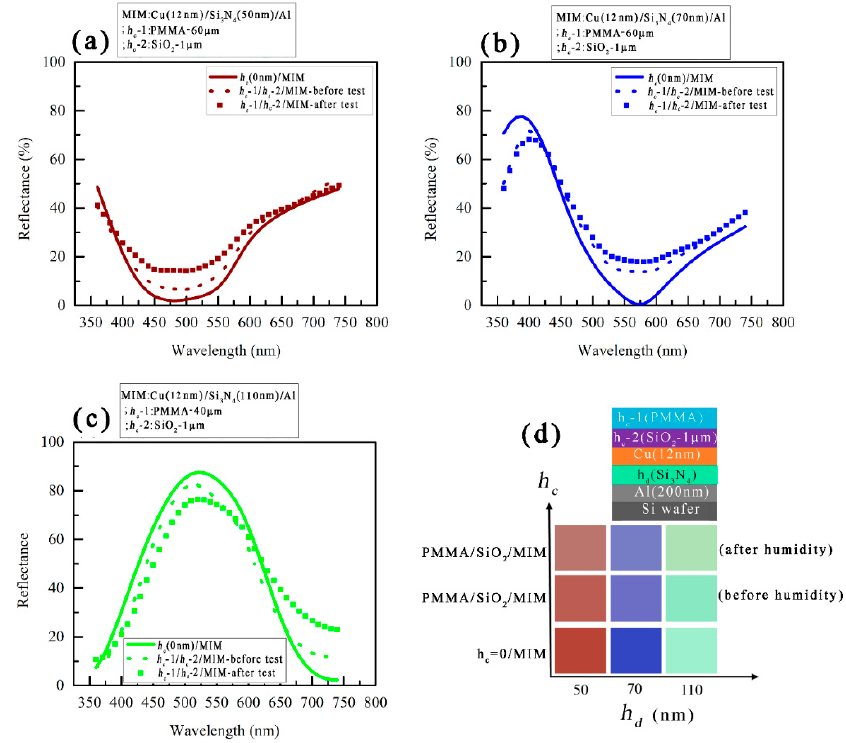
Figure 7. Reflectance spectra of uncoated and PMMA/SiO 2 coated MIM structure. The reflectance spectra after the humidity test were presented as well for comparison; ( a ) PMMA (0–60 μ m)/SiO 2 (1 μ m)/Cu (12 nm)/Si 3 N 4 (50 nm)/Al (200 nm)/Si, ( b ) PMMA (0–60 μ m)/SiO 2 (1 μ m)/Cu (12 nm)/Si 3 N 4 (70 nm)/Al (200 nm)/Si, ( c ) PMMA (0–40 μ m)/SiO 2 (1 μ m)/Cu (12 nm)/Si 3 N 4 (110 nm)/Al (200 nm)/Si structure. ( d ) Measured colors of the uncoated and PMMA/SiO 2 coated MIM structure.